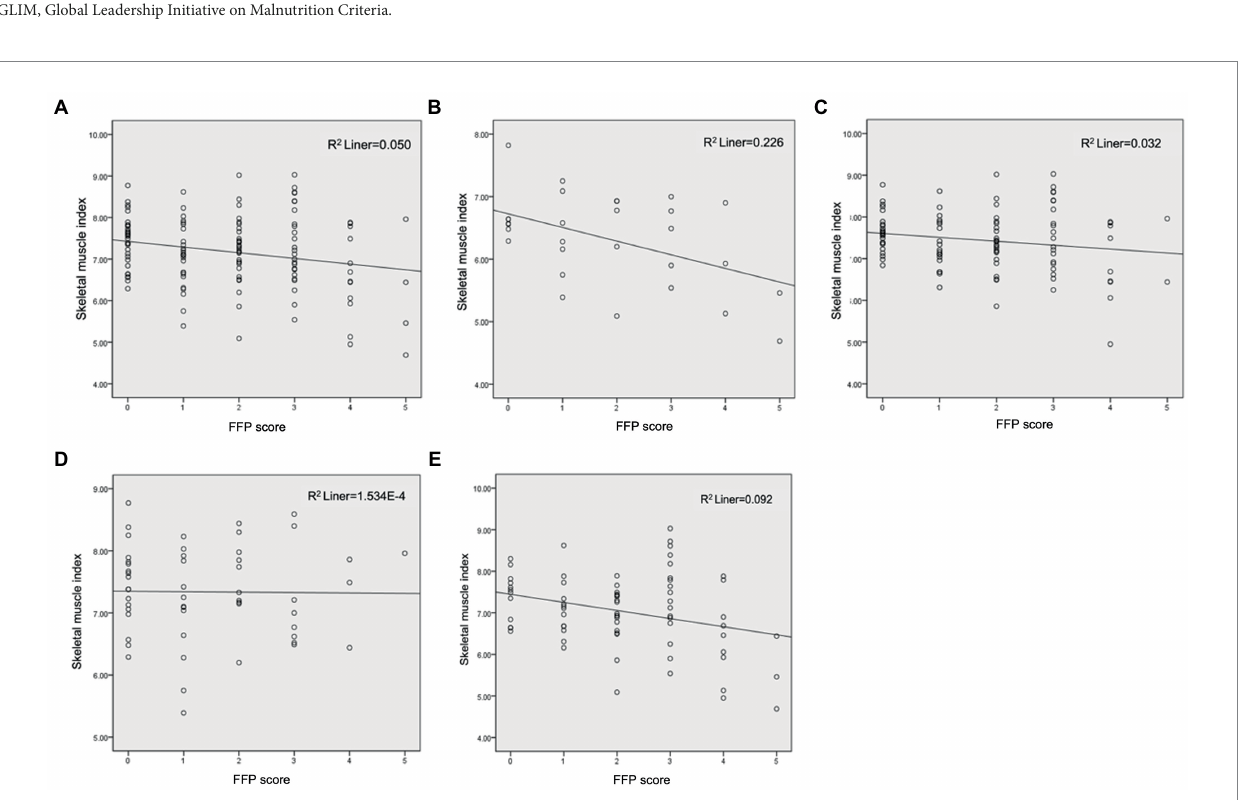
FIGURE 1 Correlation analysis of SMI and FFP. (A) Total subjects; (B) Female; (C) Male; (D) <65 years; (E) ≥ 65